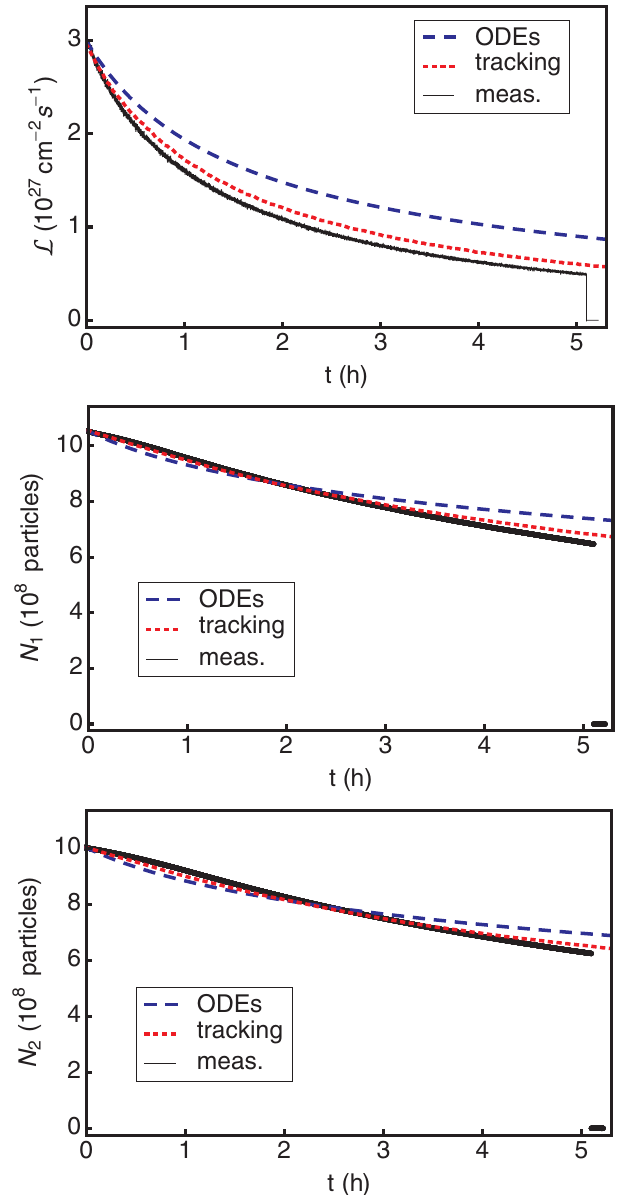
FIG. 8. (Color) The luminosity (top), Blue bunch intensity (middle), and Yellow bunch intensity (bottom) from measure- ments and two simulation methods for store 8908 in